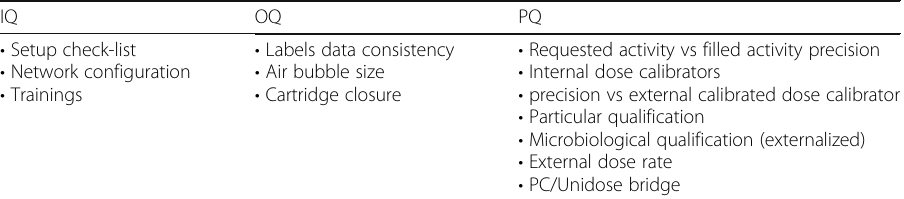
Table 1 Initial Trasis Unidose® IQ/OQ/PQ